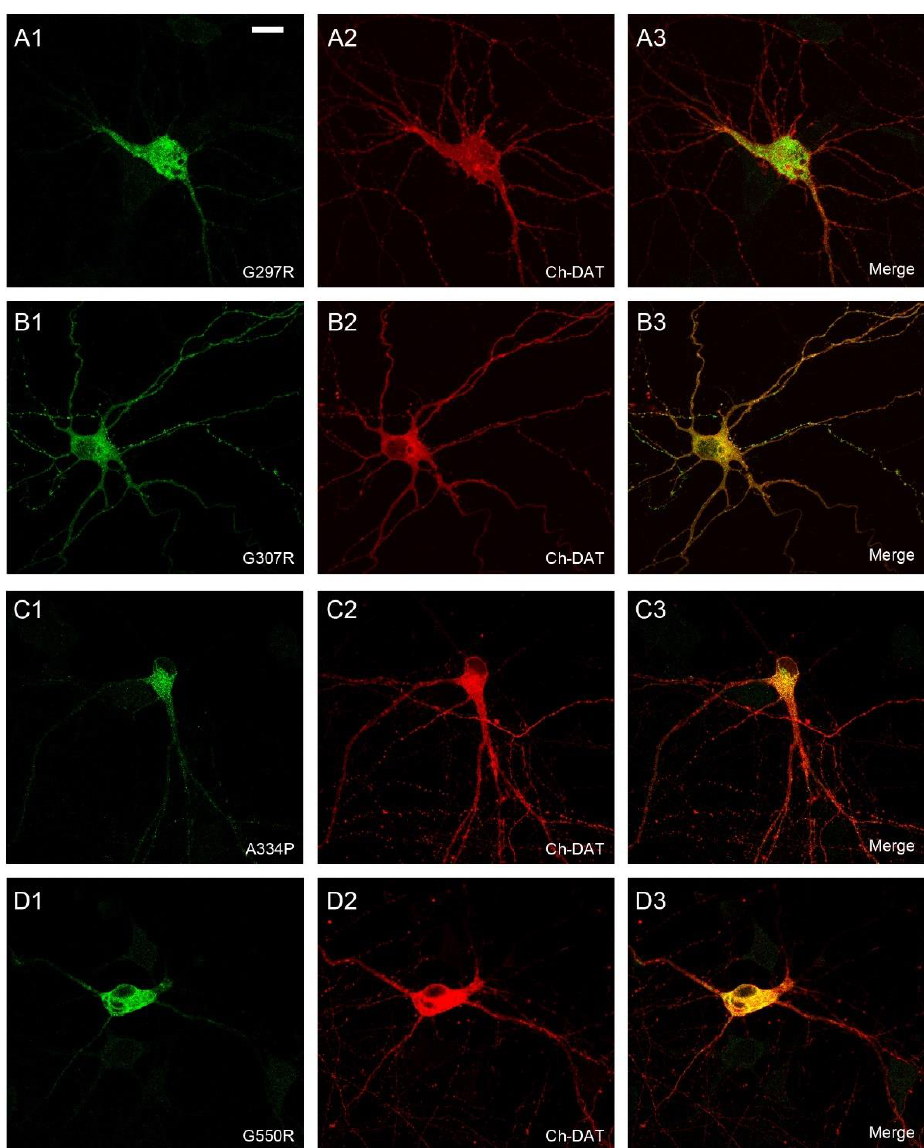
Figure 7. Subcellular distribution of GAT-1 variants in transfected neurons. Primary cultures of rat cortical neurons were co-transfected at 13 DIV with mCherry-DAT plus the indicated variants of HA-GAT-1: G297R ( A1 – A3 ); G307R ( B1 – B3 ); A334P ( C1 – C3 ); G550R ( D1 – D3 ). 48 h later, cells were fixed and incubated with anti-HA and anti-mCherry primary antibodies followed by Alexa-labeled secondary antibodies. Images collected by confocal microscopy correspond to distribution of HA-GAT-1 variants (green channel; A1 , B1 , C1 , D1 ), mCherry-DAT (red channel; A2 , B2 , C2 , D2 ) or the merge ( A3 , B3 , C3 , D3 ). Scale bar: 15 µm.